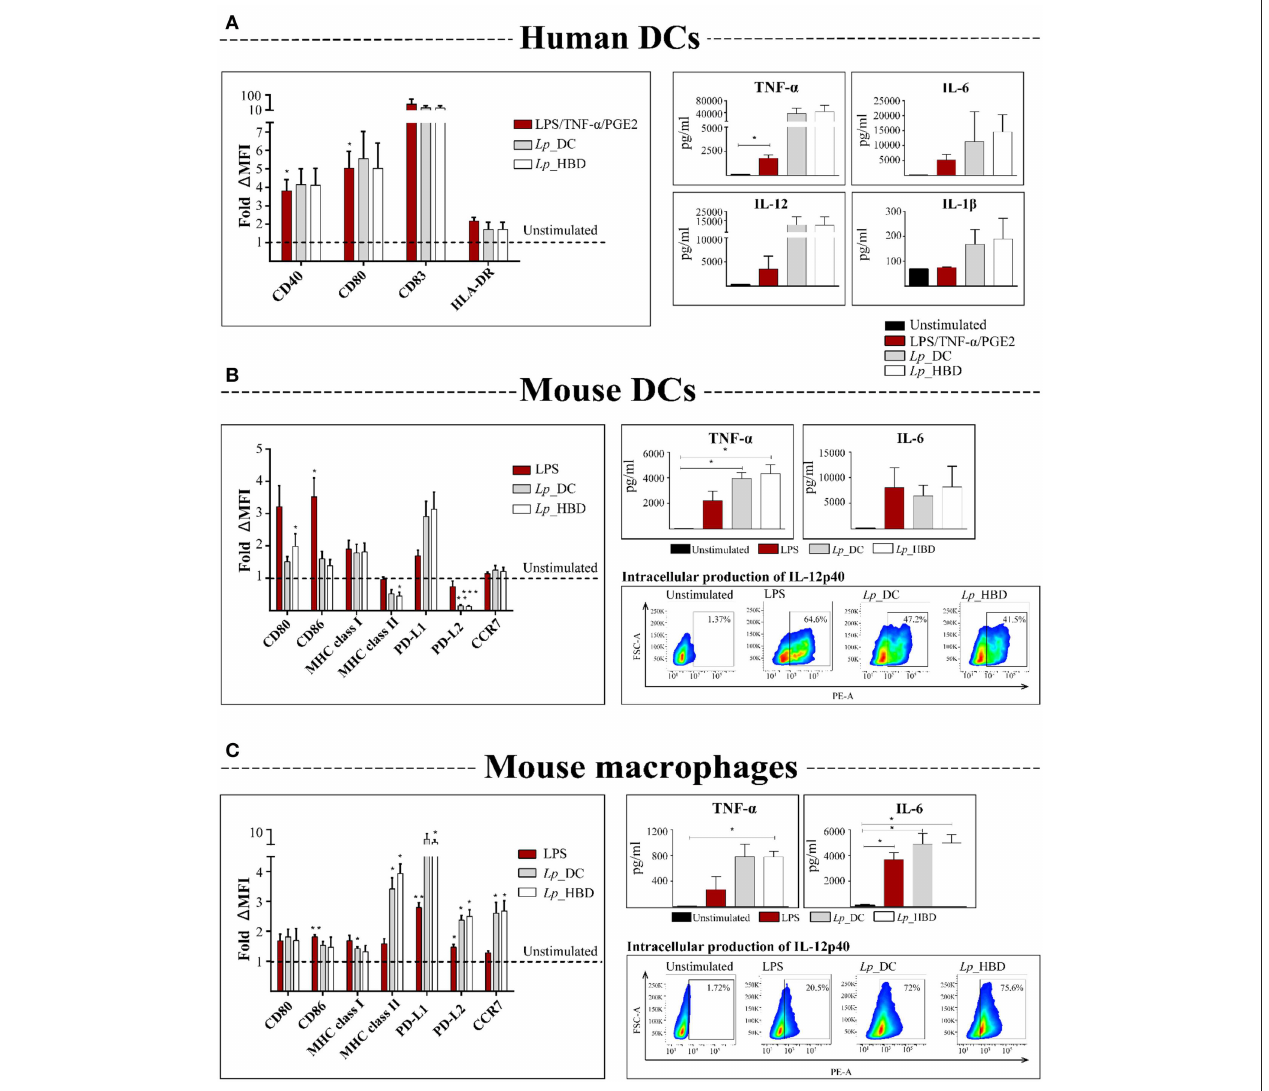
FIGURE 4 | Activation of human DCs (A) , mouse DCs (B), and mouse macrophages (C) by UV-inactivated lactobacilli. APCs were incubated with Lp _DC or Lp _HBD at MOI of 200 for human cells and 100 for mouse cells, for 24 or 48h. Expression of surface co-stimulatory molecules was measured by flow cytometry and the median fluorescence intensity (MFI) was normalized to the unstimulated controls. Pro-inflammatory cytokines in culture supernatants were quantified by ELISA. IL-12p40 in mouse APCs was detected by intracellular staining followed by flow cytometry and the plots are from a representative experiment of cells stimulated with LPS (100ng/mL), Lp _DC or Lp _HBD. For human DCs (A) , three blood donors were tested and the data are shown as a mean ± SEM. The results for mouse cells (B,C) are presented as a mean from three independent experiments and the data are shown as a mean ± SEM. Statistically significant differences were tested against the unstimulated controls using paired t -test and are indicated as follows: * p < 0.05, ** p < 0.01, and *** p <